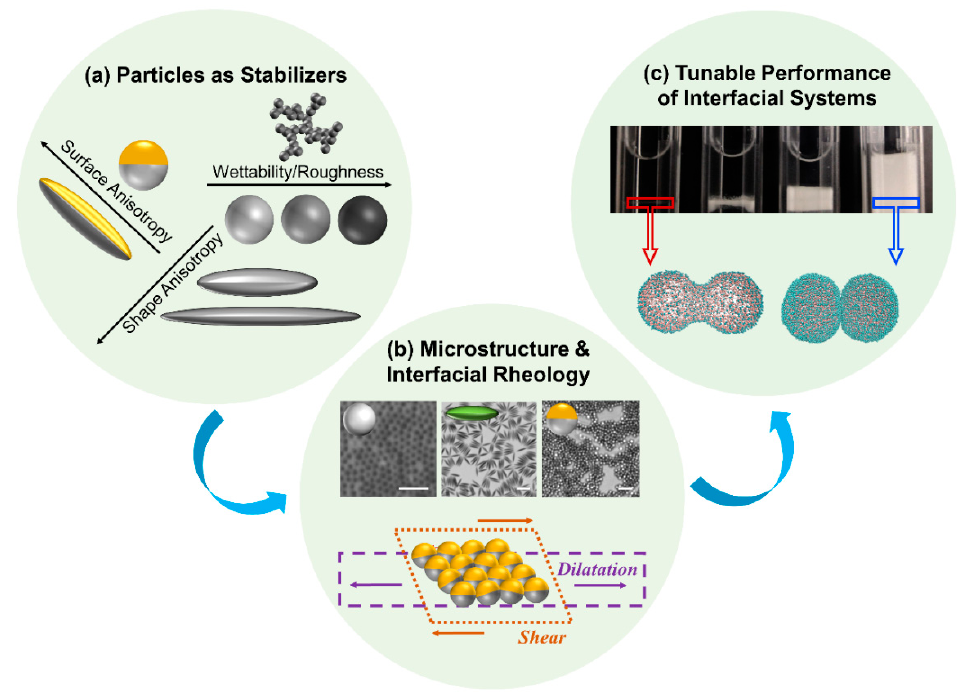
Figure 1. (Color online) Particle-stabilized interfacial systems: ( a ) schematics of particle attributes affecting their microstructure at a fluid interface; ( b ) different microstructures resulting from spherical homogeneous particles vs. ellipsoidal homogeneous particles vs. spherical Janus particles at the air/water interface (scale bar is 5 μ m); representation of both interface deformation modes imposed on the interface, i.e., dilatation and shear; ( c ) rectangular test tubes (2 by 8 mm polycarbonate cells) containing Pickering emulsions with different degrees of stability along with Dissipative Particle Dynamics simulations of the coalescence of emulsion droplets (droplet diameter 27 nm) [105].